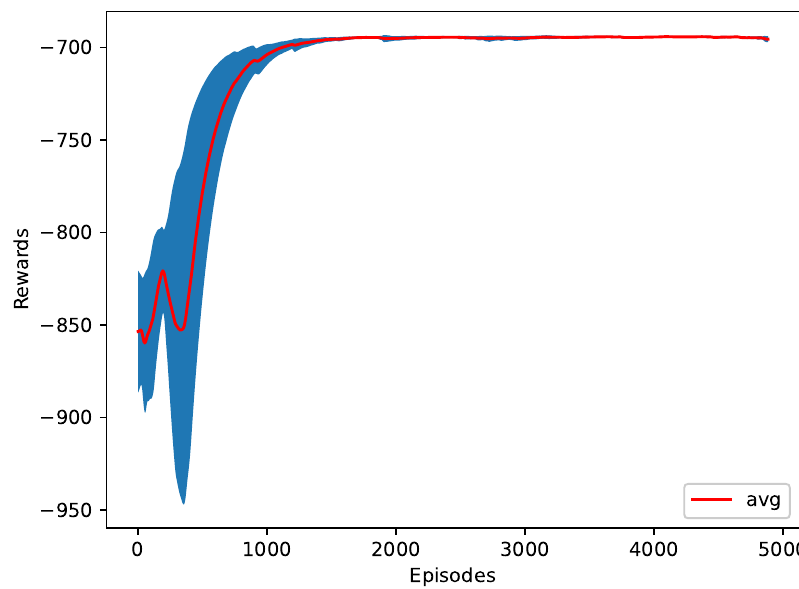
Figure 13. The training plot of the maximum jerk as a reward